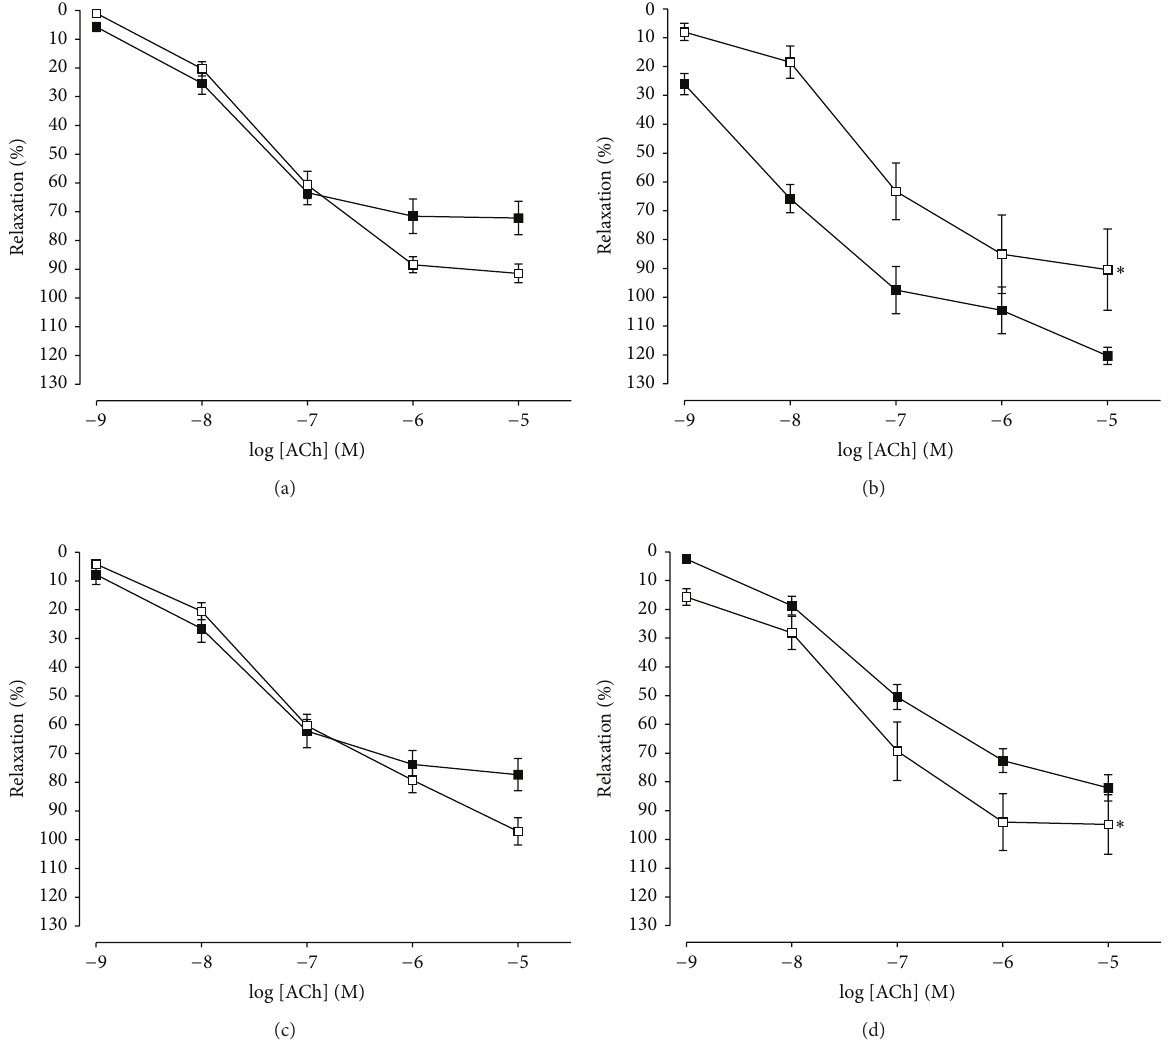
Figure 4: ACh-induced relaxation responses of aortic rings precontracted with PE (1 𝜇 M) in the presence of indomethacin (10 𝜇 M) in control (vehicle) (a), losartan (10mg/kg) (b), WOS (1000mg/kg) (c), and WMOS (1000mg/kg) (d). Responses to ACh are expressed as percentage of relaxation. Values are mean ± SEM of 5 to 6 SHRs in each group. ∗ Denotes 𝑃 < 0.05 compared to ACh without indomethacin ( ◼ ).